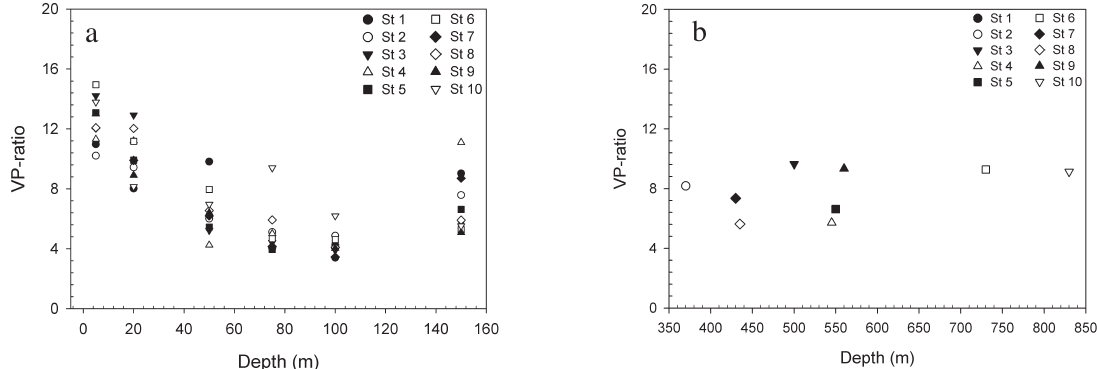
F IG . 5. Virus-like particles/prokaryote ratio (VP-ratio) in the (a) water column (5 - 150 m) and (b) benthic boundary layer on Bajo O’Higgins 1